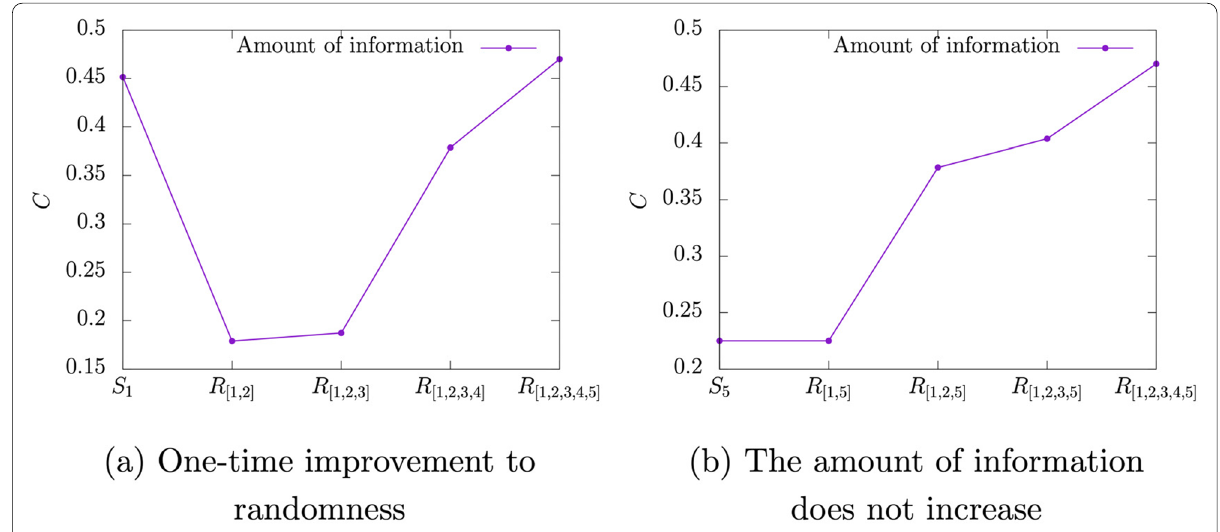
Fig. 9 Remarkable examples of the reconstruction process in the basic scheme